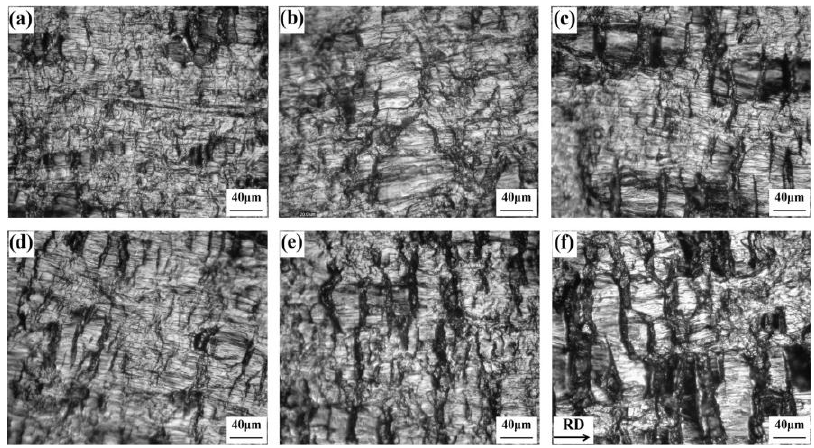
Figure 4. Optical microscope (OM) images of the Ti ( a – c ) and Cu ( d – f ) peeled surfaces, roll-bonded at the different thickness reductions of 44% ( a , d ), 56% ( b , e ) and 62% ( c , f ) [44].